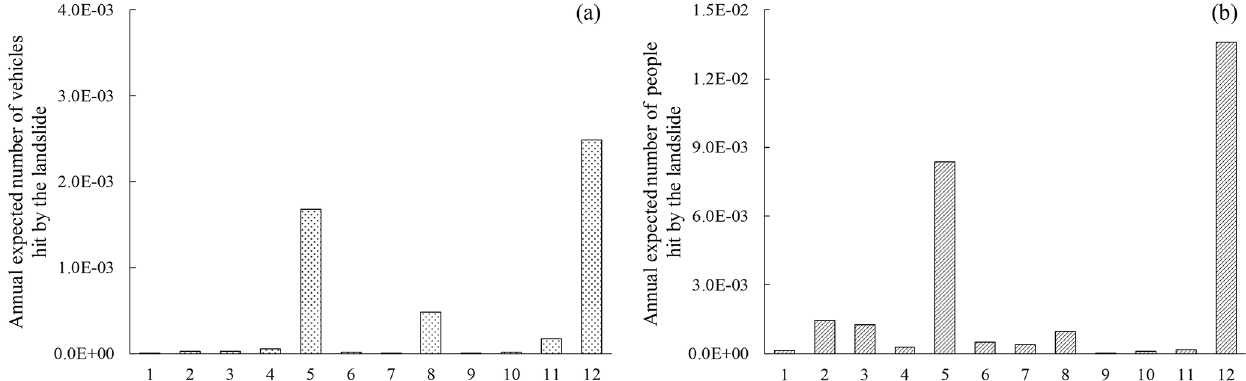
Figure 10. Annual expected number of elements, (a) vehicles and (b) people, hit by the landslide studied in this paper. The numbers on the x axis refer to the following vehicle types: 1 – private buses, 2 – non-franchised public buses, 3 – franchised buses, 4 – taxis, 5 – private cars, 6 – public light buses, 7 – private light buses, 8 – goods vehicles, 9 – special-purpose vehicles, 10 – government vehicles, 11 – motor cycles and 12 – all types of vehicles.